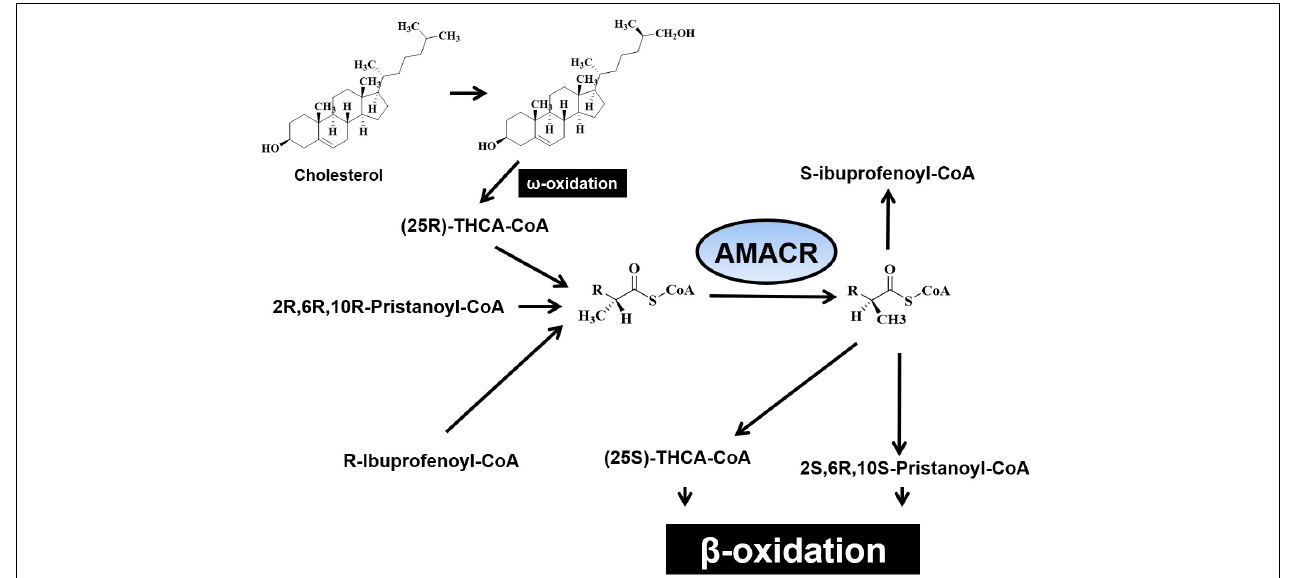
FIGURE 6 | Structure of α -methyl-branched-chain fatty acyl-CoA